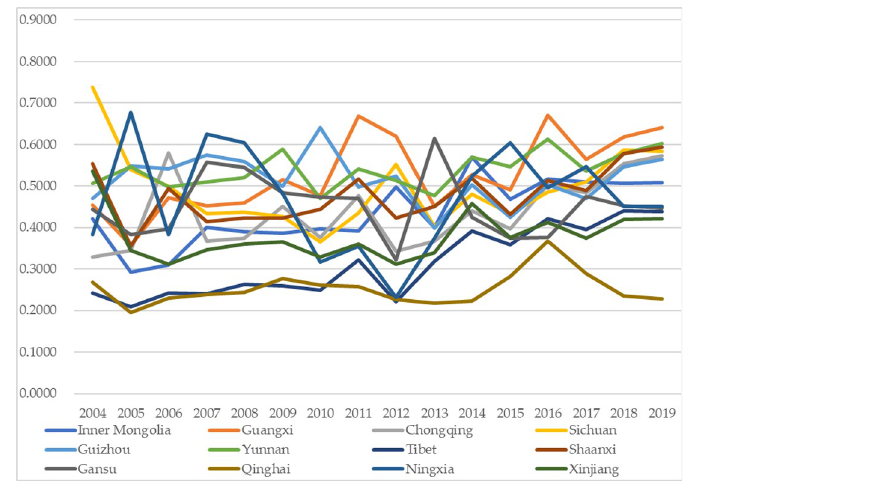
Fig 4. Performance of the environmental governance